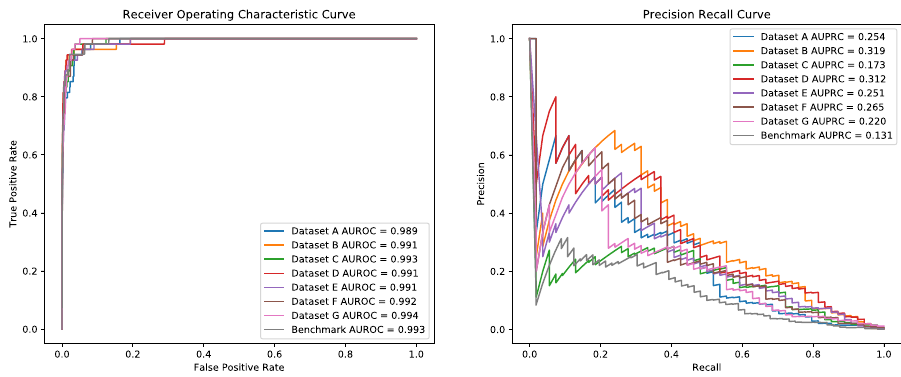
Figure 6. Performance of R-CRISPR with different training datasets on Dataset GUIDE_II.